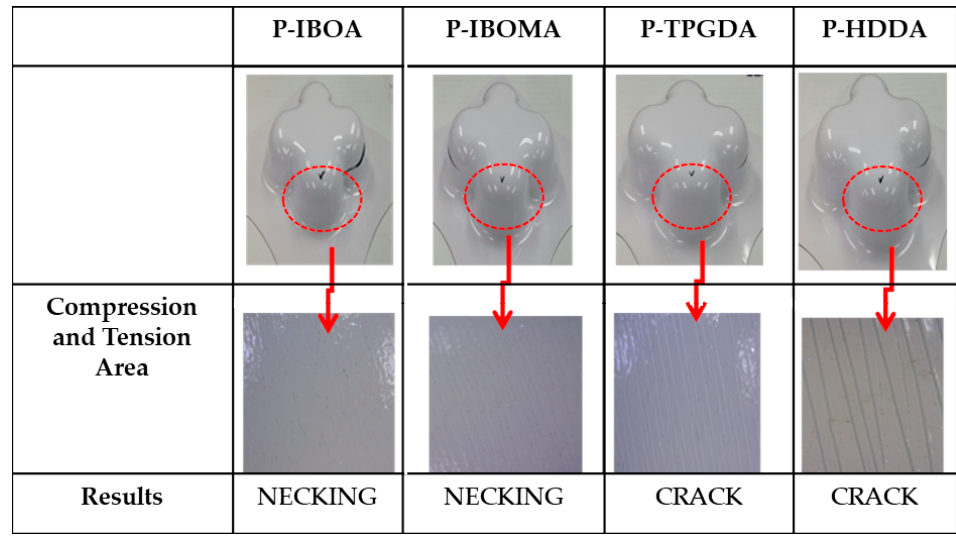
Figure 11. Compression and tension images of UV-cured PUA coating films. Film Properties by Curing